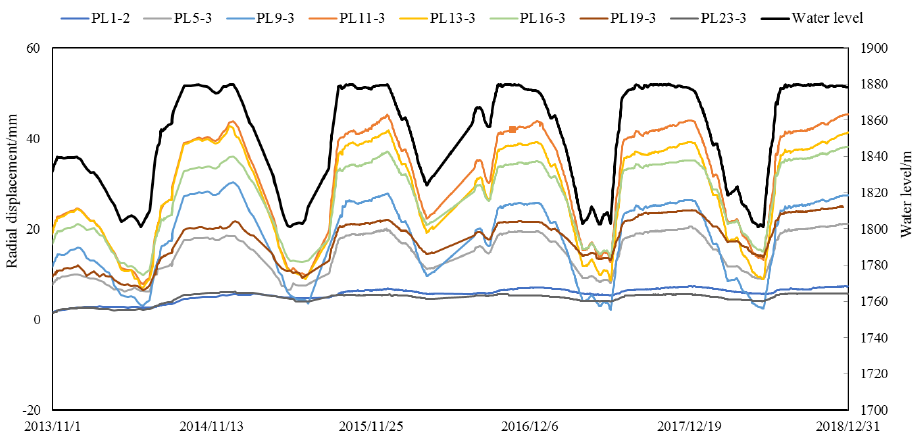
Figure 15. Time series of several radial displacement of some dam sections and water level.